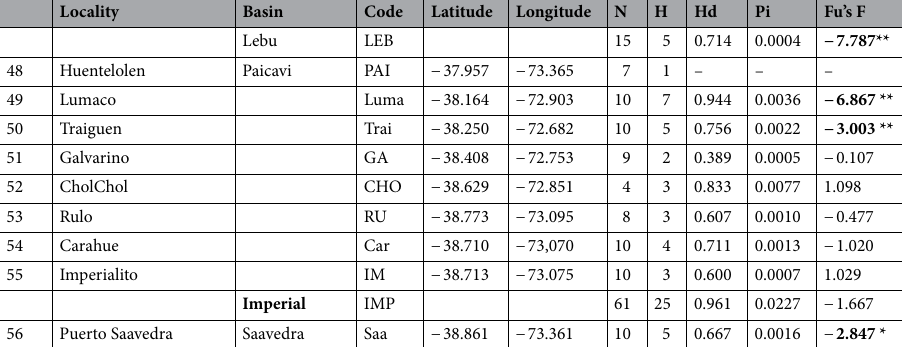
Table 1. Sampling localities of specimens of Parastacus pugnax . Localities are presented from north to south and are grouped by river basin. Andean basins are indicated in bold. N, sample sizes; H, number of haplotypes; Hd, haplotype diversity; Pi, nucleotide diversity; Fs, Fu´s demographic statistics. Statistically significant values (* p < 0.05; ** p < 0.001) are shown in